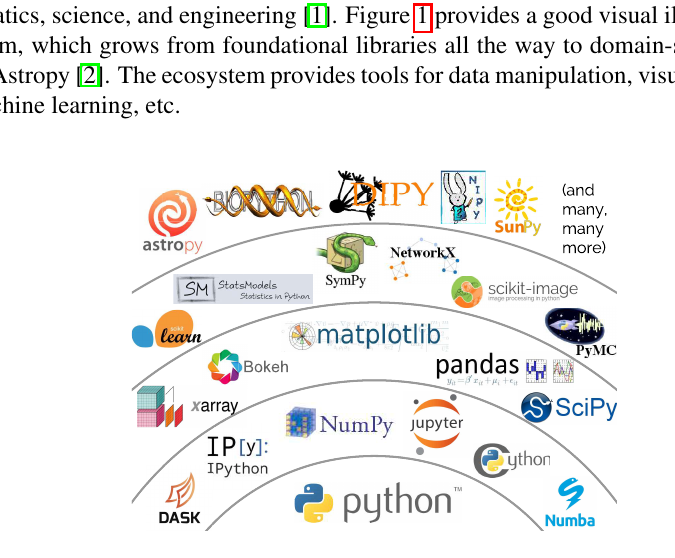
Figure 1. Schematic view of the Python scientific software ecosystem. Figure taken from Jake Vander- Plas’s presentation at the PyCon 2017 conference